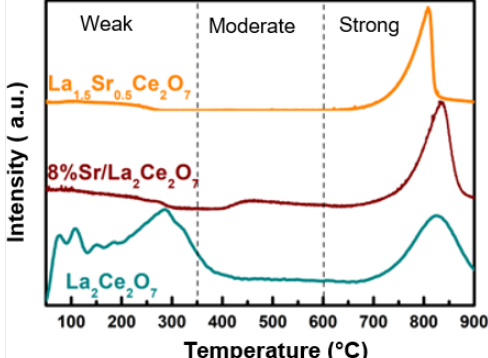
Figure 10. CO 2 -TPD profile of the indicated catalysts [89]. Table 5. CO 2 -TPD quantification results of the catalysts [89].